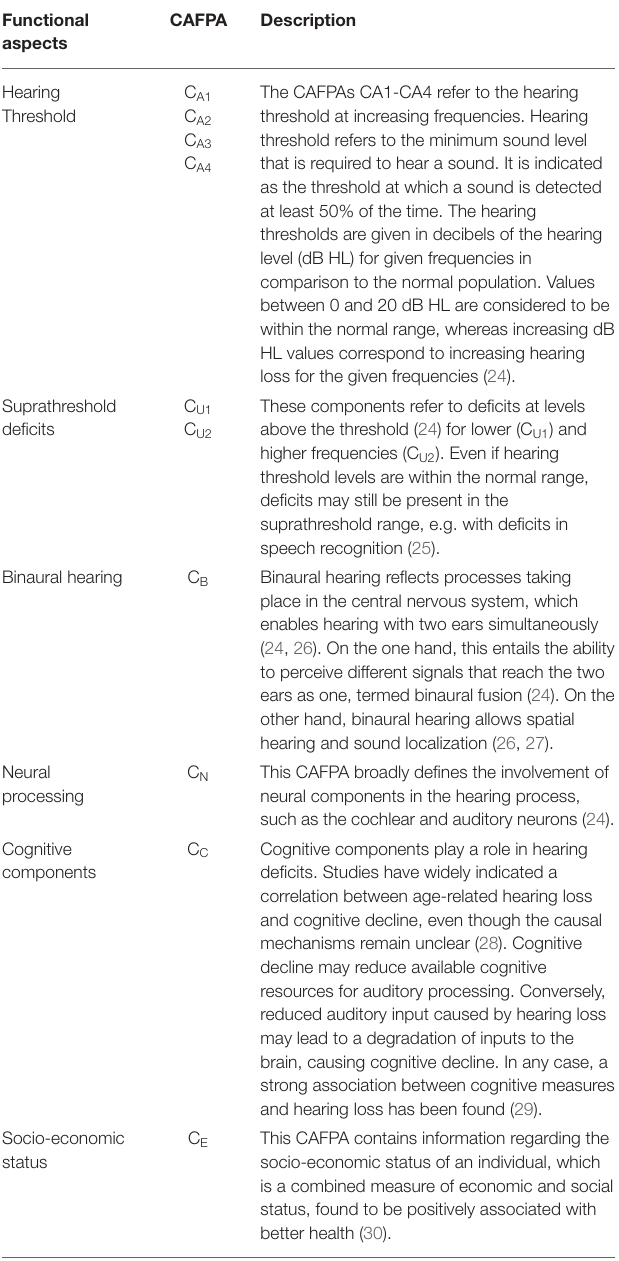
TABLE 1 | Overview and description of